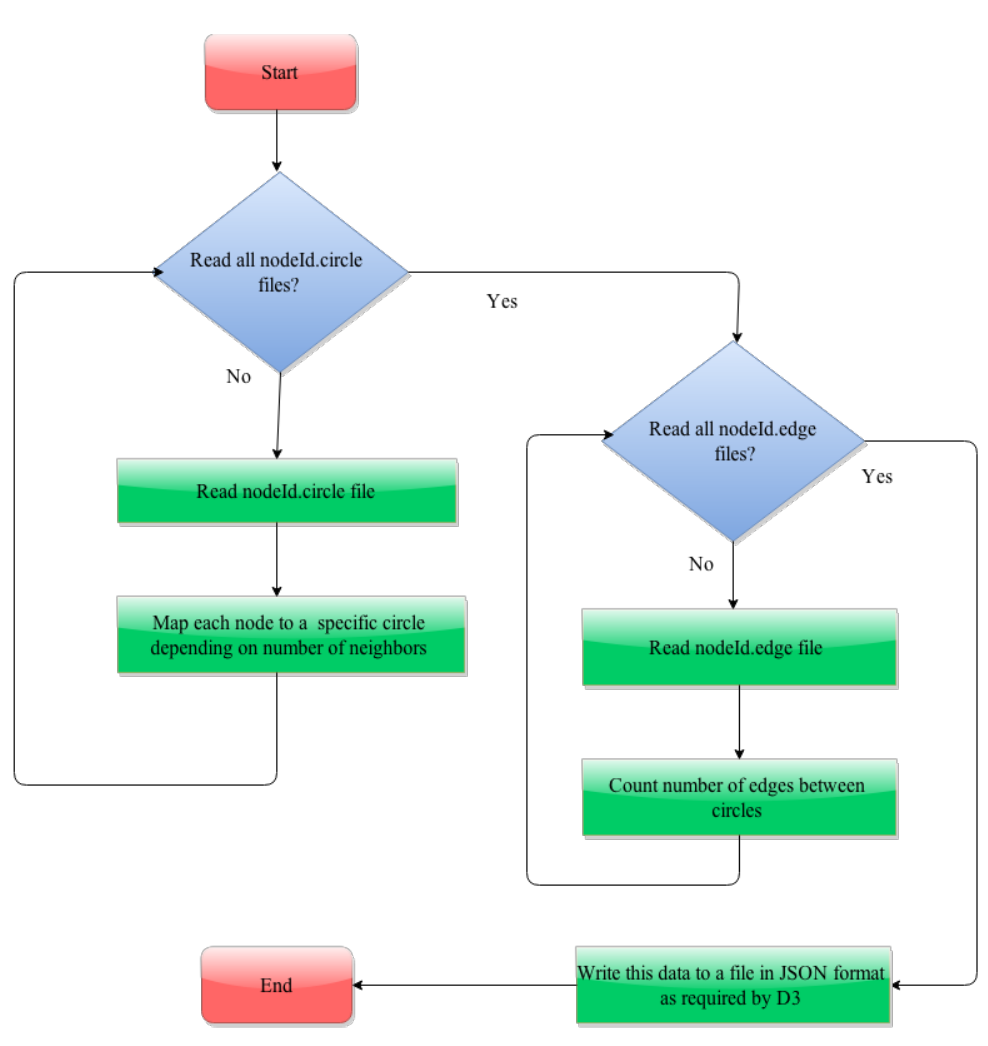
Figure 5. A flow chart to show the steps involved in the generation of the JSON (JavaScript Object Notation) file containing the interactions between